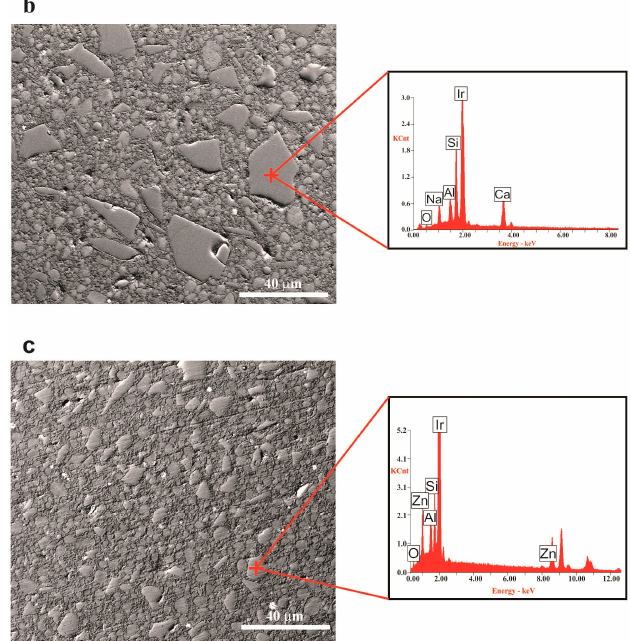
Figure 3. Scanning electron micrographs of the polished cross-sectioned control composite ( a ) and the corresponding EDS analysis; composite containing G3-GC26 ( b ) and the corresponding EDS analysis of the G3-GC particles; composite containing 35ZnO-G26 ( c ) and the corresponding EDS analysis of the 35ZnO-G particles.